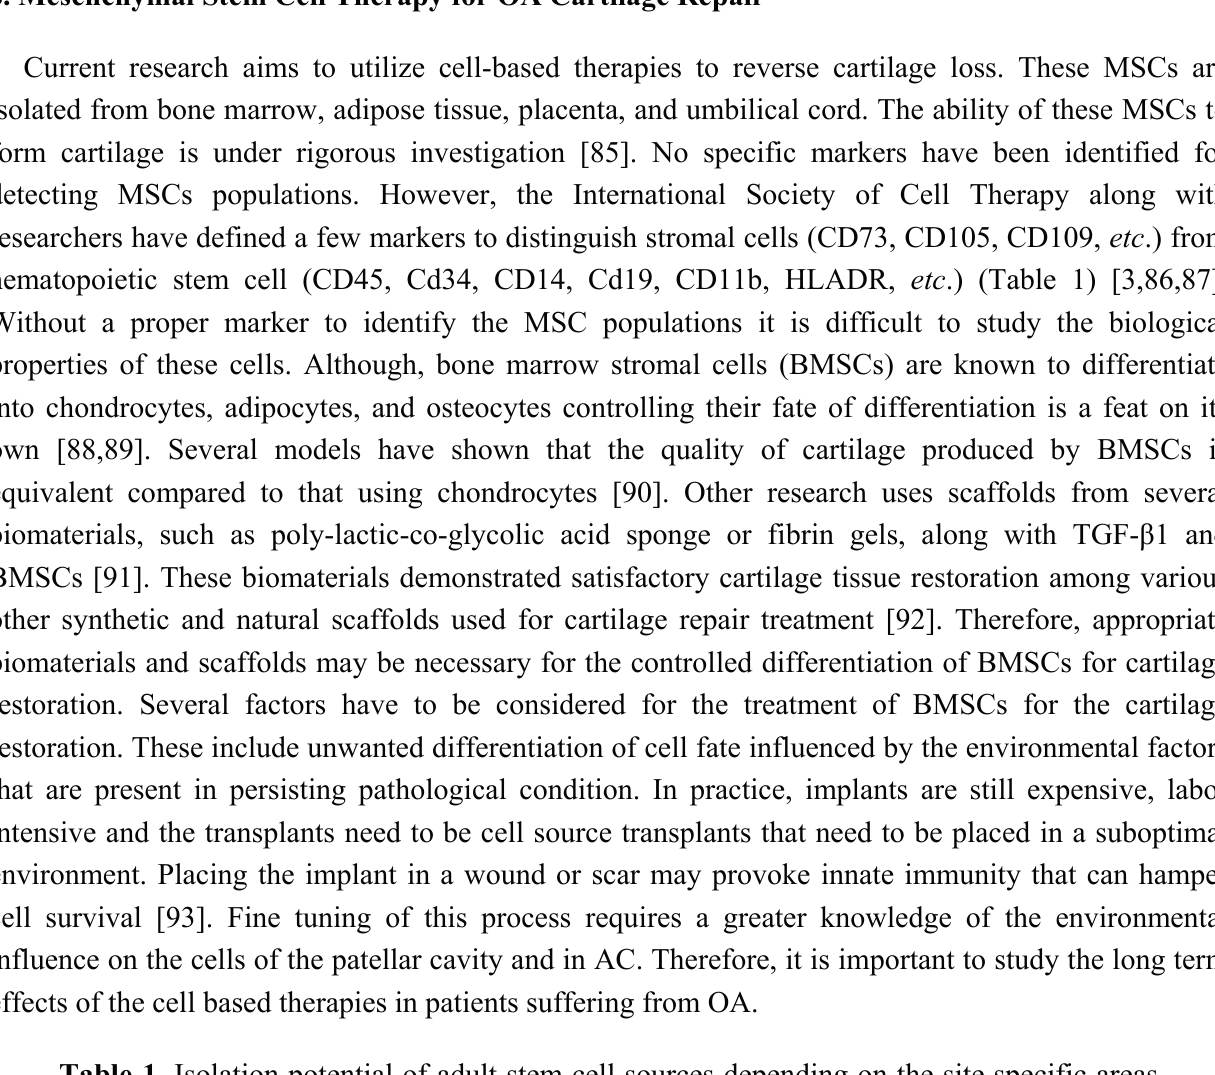
Table 1. Isolation potential of adult stem cell sources depending on the site specific areas of the patellar